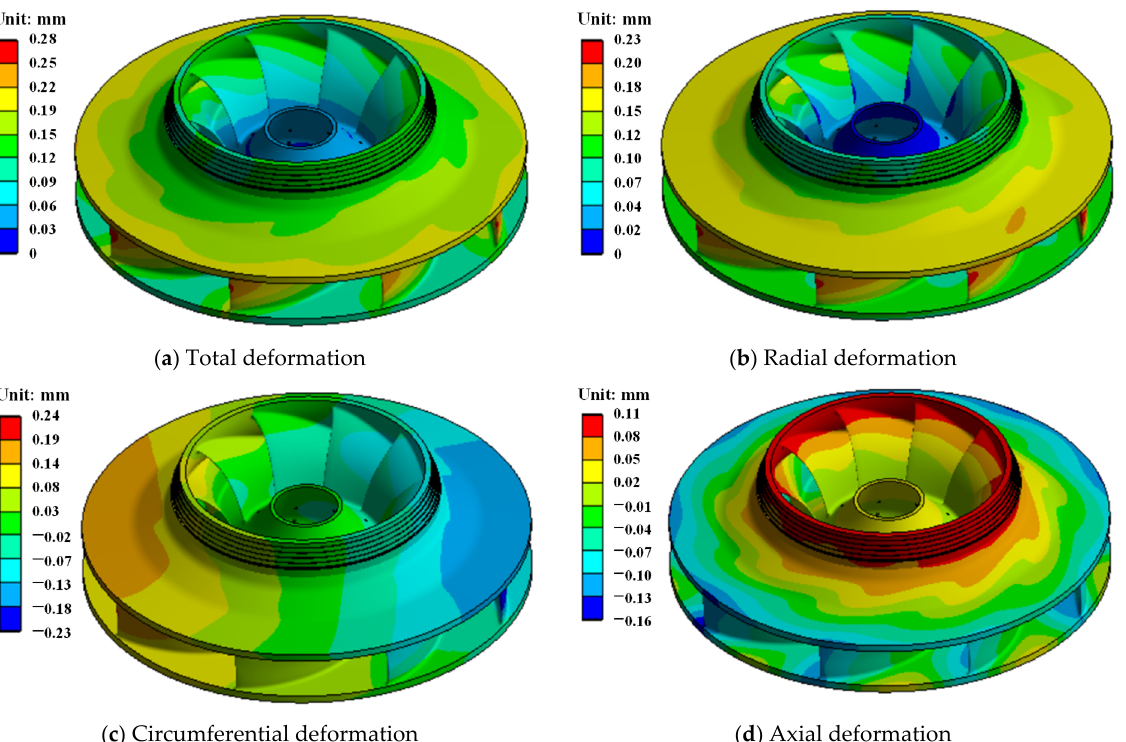
Figure 9. Total and directional deformations of the runner in rated operating condition.